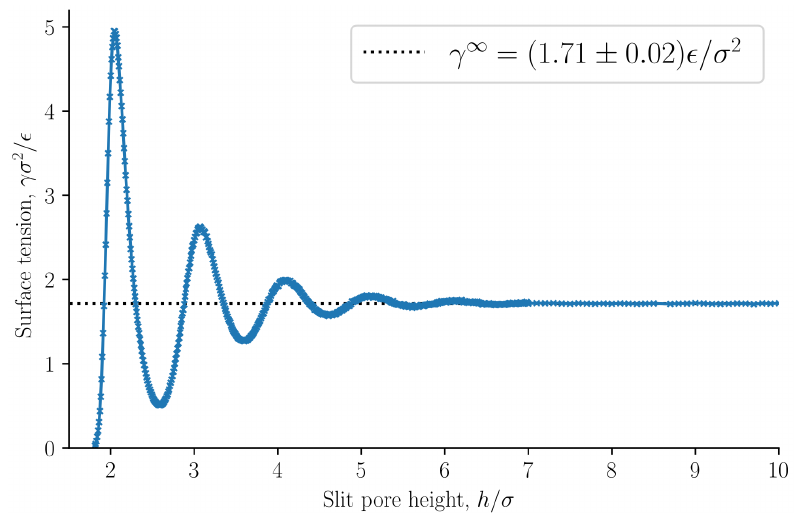
Figure 8. Surface tension γ as a function of slit pore height h , see Equation (33). The dashed line shows the surface tension at infinite separation γ ∞